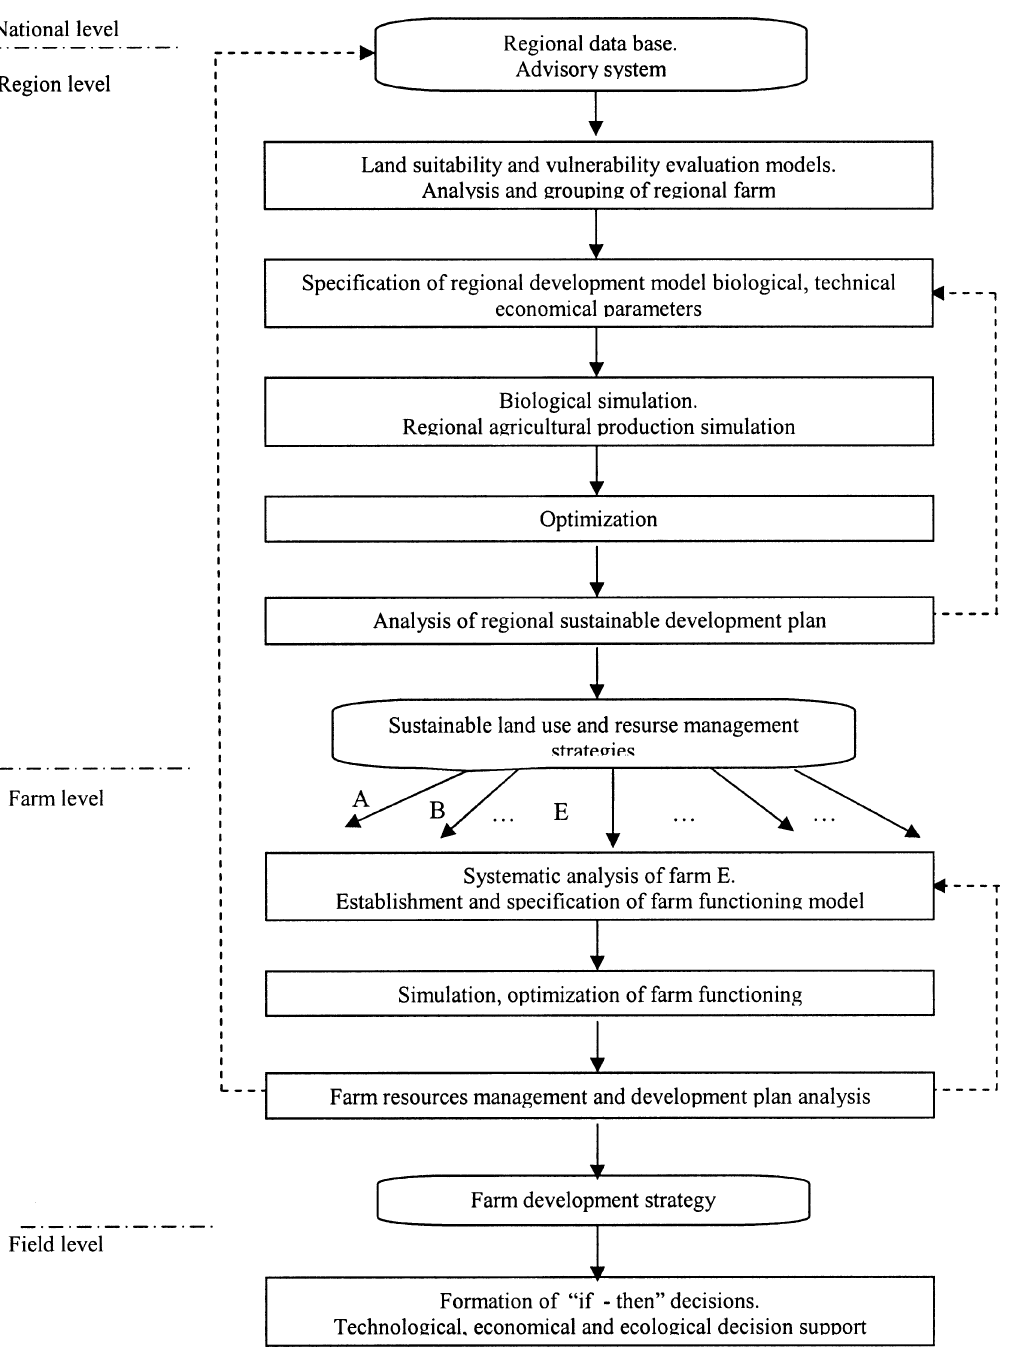
(cid:26)(cid:23)(cid:1)(cid:26)(cid:8)(cid:31)(cid:28)F(cid:16)(cid:22)(cid:13)(cid:16)(cid:31)(cid:26)(cid:22)(cid:1)(cid:30)5F(cid:13)3(cid:31)(cid:1)#3(5(cid:22)(cid:30)(cid:1)73(cid:31)(cid:1)(cid:31)5(cid:8)(cid:28)3(cid:23)(cid:26)(cid:22)(cid:1)D3(cid:22)(cid:28)F2(cid:1)(cid:26)(cid:23)(cid:26)(cid:22)2(cid:30)(cid:28)(cid:30)(cid:1)(cid:26)(cid:23)((cid:1)(cid:30)(cid:13)(cid:31)(cid:26)(cid:13)5(cid:8)(cid:28)F(cid:1)D(cid:22)(cid:26)(cid:23)(cid:23)(cid:28)(cid:23)(cid:8)